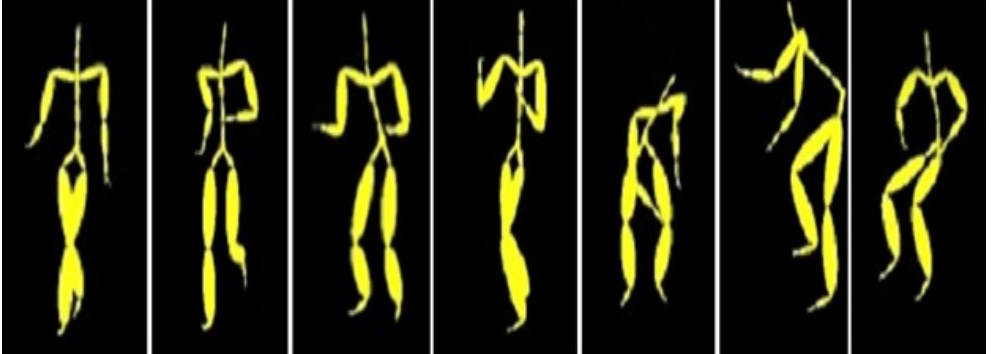
Figure 2. Illustration of different human